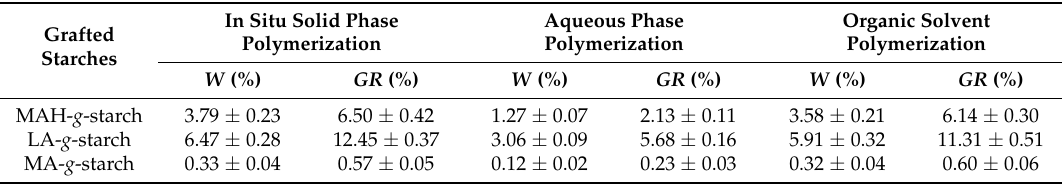
Table 1. Grafting ratio of three kinds of grafted starches.